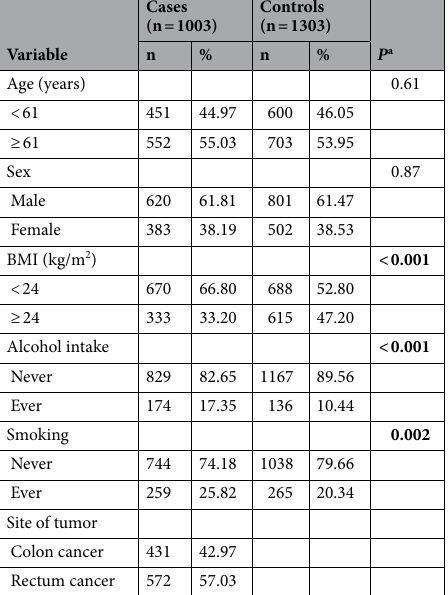
Table 2. Primary information for LncRNA rs 944289 C>T and rs7990916 C>T polymorphisms. a MAF: minor allele frequency; b HWE: Hardy–Weinberg